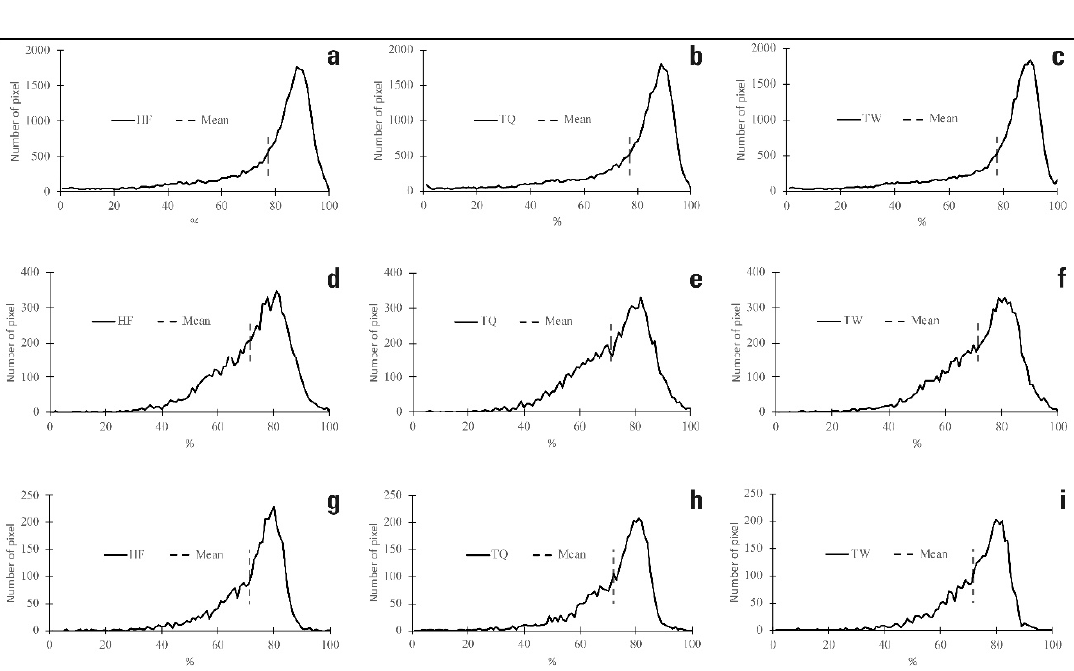
Figure 9. Histograms of derived ISAs from a subset area highlighted in Figure 6. The X-axis is percent ISA and the Y-axis is the total number of ISAs derived from images with half (HF), three-quarters (TQ), and twice (TW) the OLI SNRs at 10-m ( a – c ), 20-m ( d – f ), and 30-m ( g – i ) resolutions. The central vertical dashed lines in each panel represent the mean of the ISAs in each estimate.